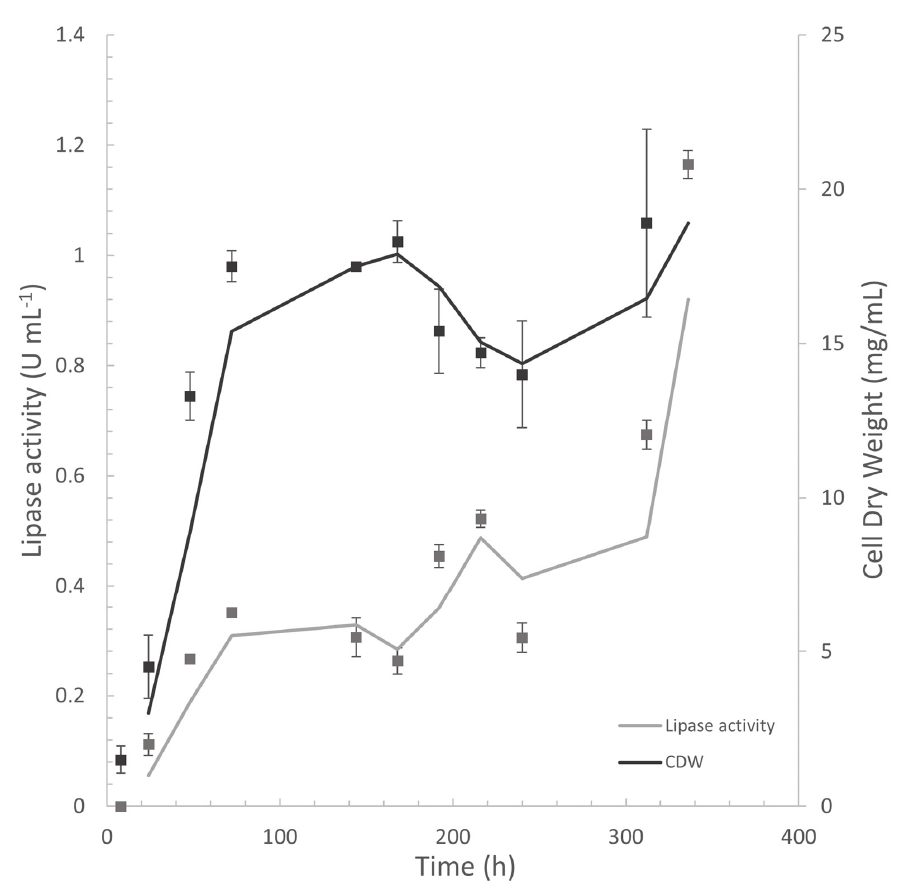
Figure 4. Lipase activity data and growth data for up-scale batch cultures of Y. lipolytica W29 cells grown in condition C media supplemented with 10% v v − 1 waste cooking oil. Data are mean values of three different measurements, and bars represent standard